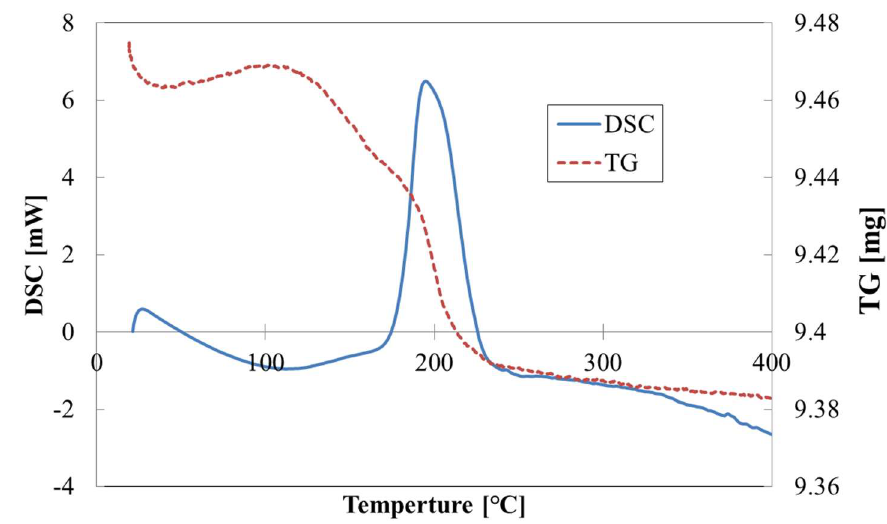
ff erential scanning calorimetry (TG–DSC) curves of the Pt Figure 2. Thermogravimetry–differential scanning calorimetry (TG–DSC) curves of the Pt catalyst. Figure 2. Thermogravimetry–di